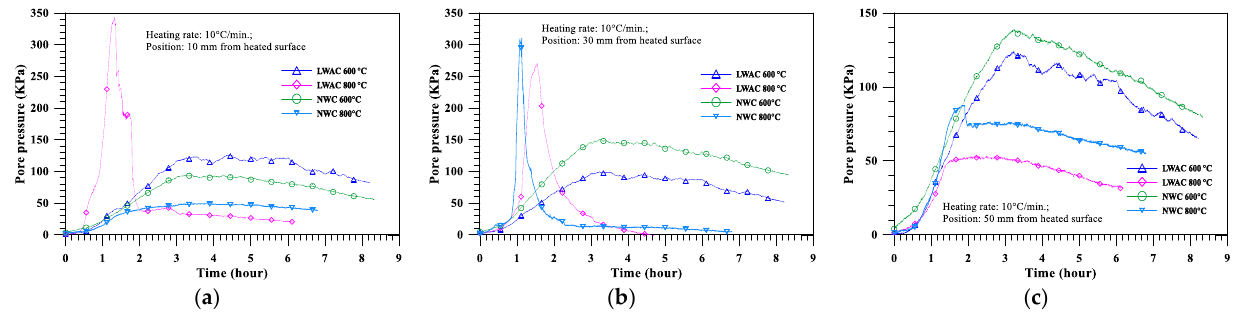
Figure 17. The effect of the target temperature on the pore pressure of the oven-dried specimens performed at a heating rate of 10 °C/min: ( a ) 10; ( b ) 30; ( c ) 50 mm